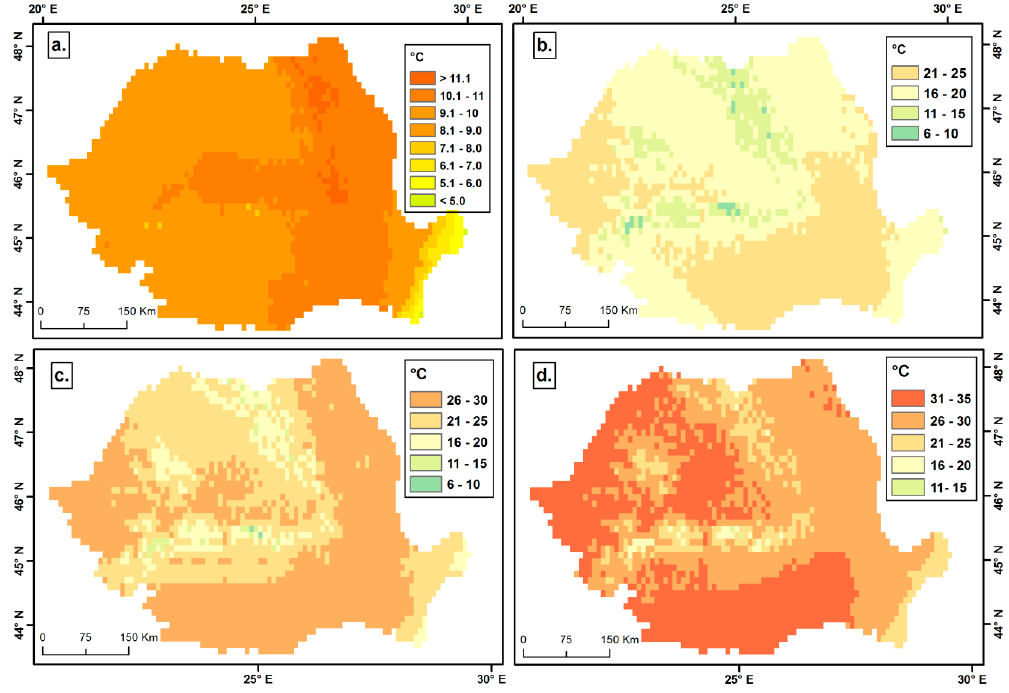
Figure 12. Mean maximum temperature anomaly in Romania in spring and autumn ( a ); and mean maximum temperature in: March/November ( b ); April/October ( c ); and May/September ( d ), for B2 HW/WS type based on the ROCADA gridded database.